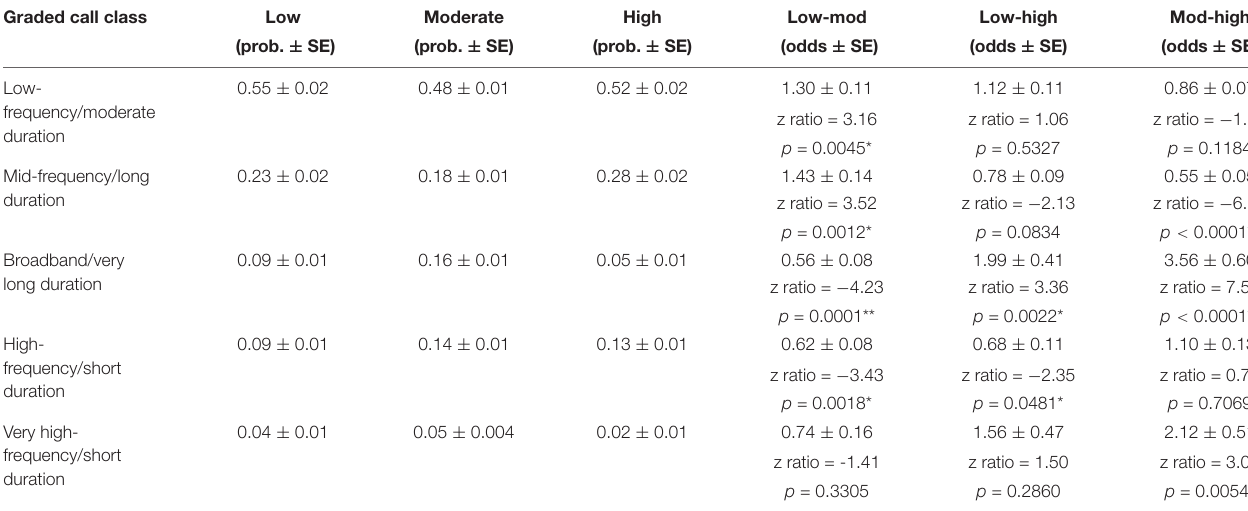
Odds ratios indicate the odds of detecting that call type in the first intensity level listed compared with the second intensity level listed. *Indicates statistical significance at the p < 0.05 level; ** indicates statistical significance at the p < 0.001 level.